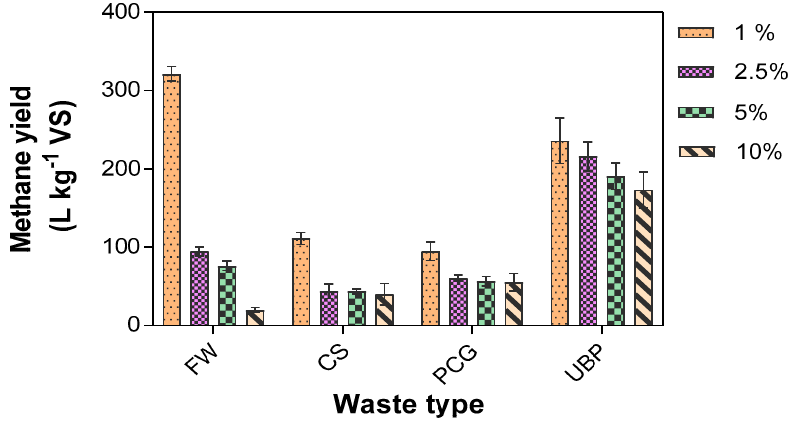
Figure 1. The methane yield from different organic loadings of food waste (FW), corn stover (CS), prairie cord grass (PCG), and unbleached paper (UBP). The data represented are the average values of the triplicate bottles. The error bars represent the standard deviation.